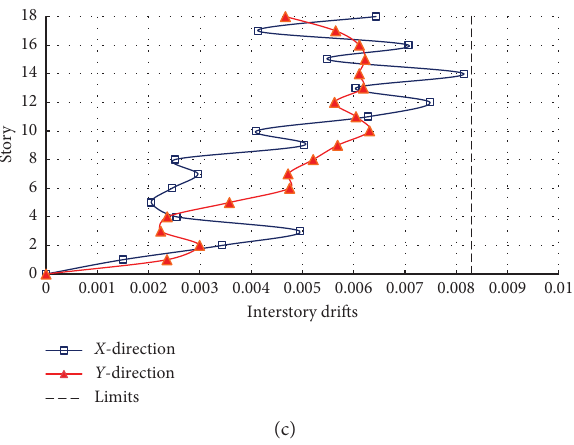
Figure 19: Mean maximum interstory drifts. (a) TR1. (b) TR2. (c)